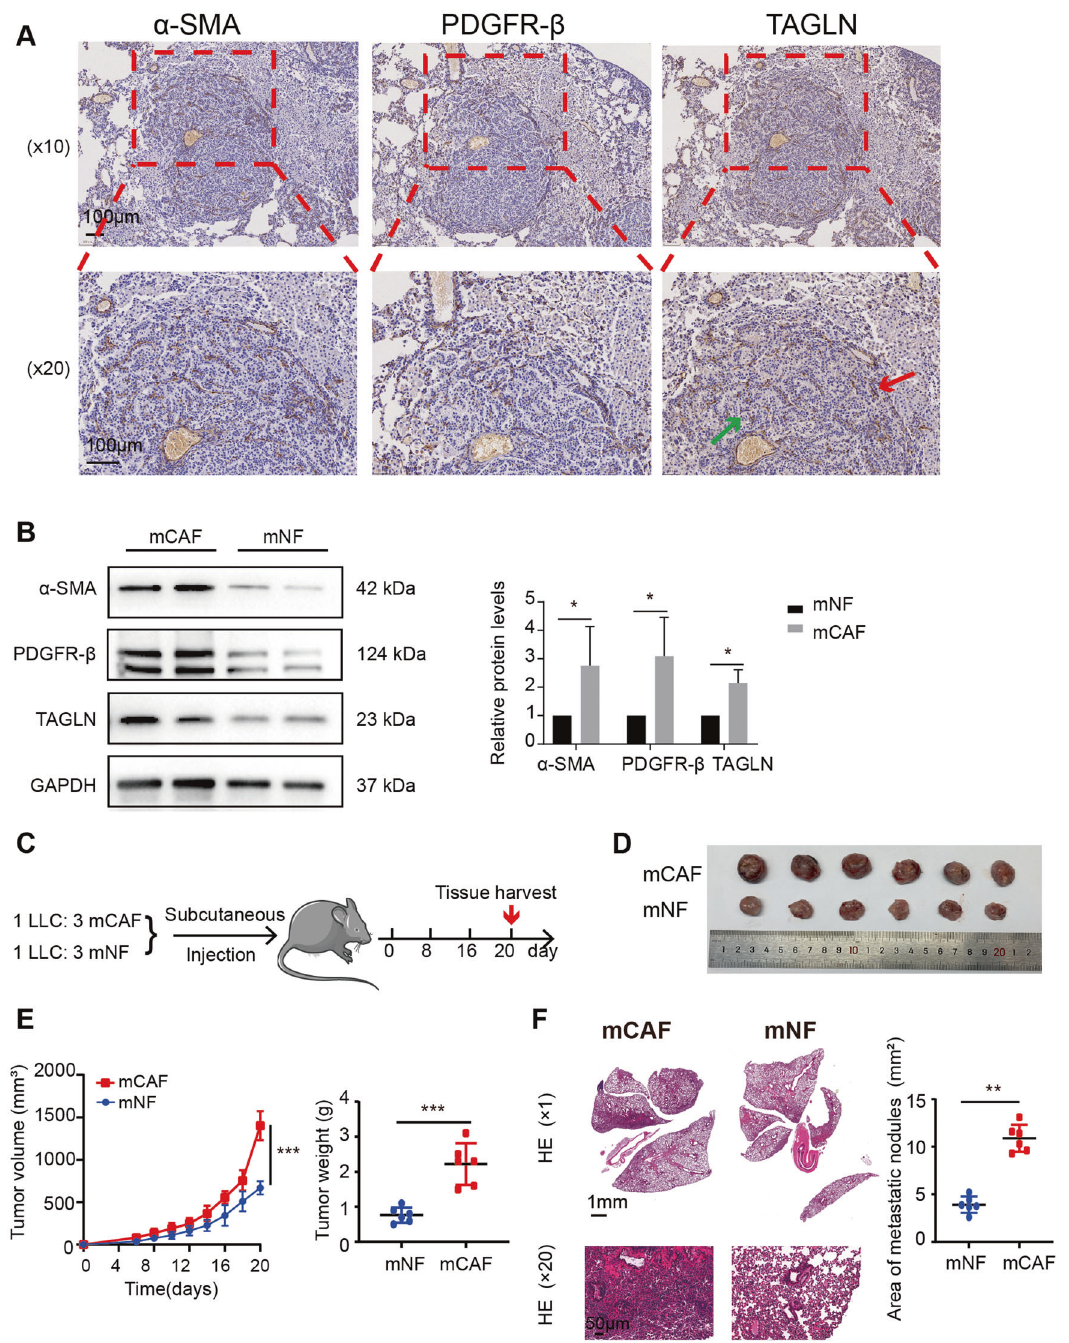
1 mm; lower panel scale bar: 50 µm. Results are shown as mean ± SEM and compared by unpaired t -test. *** p < 0.001, ** p < 0.01, * p <